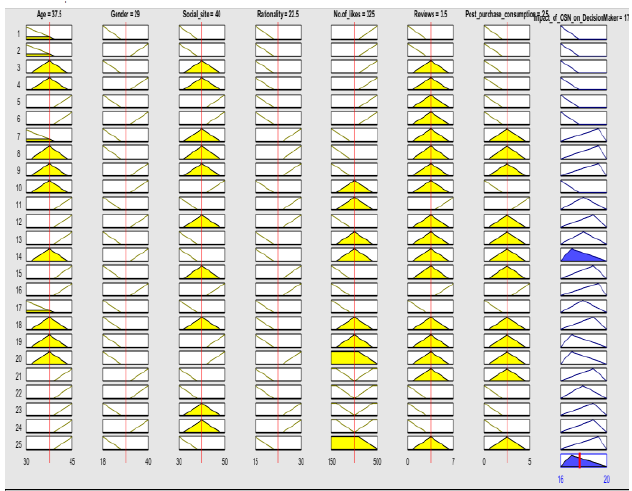
Figure 10. Rule viewer and symmetry